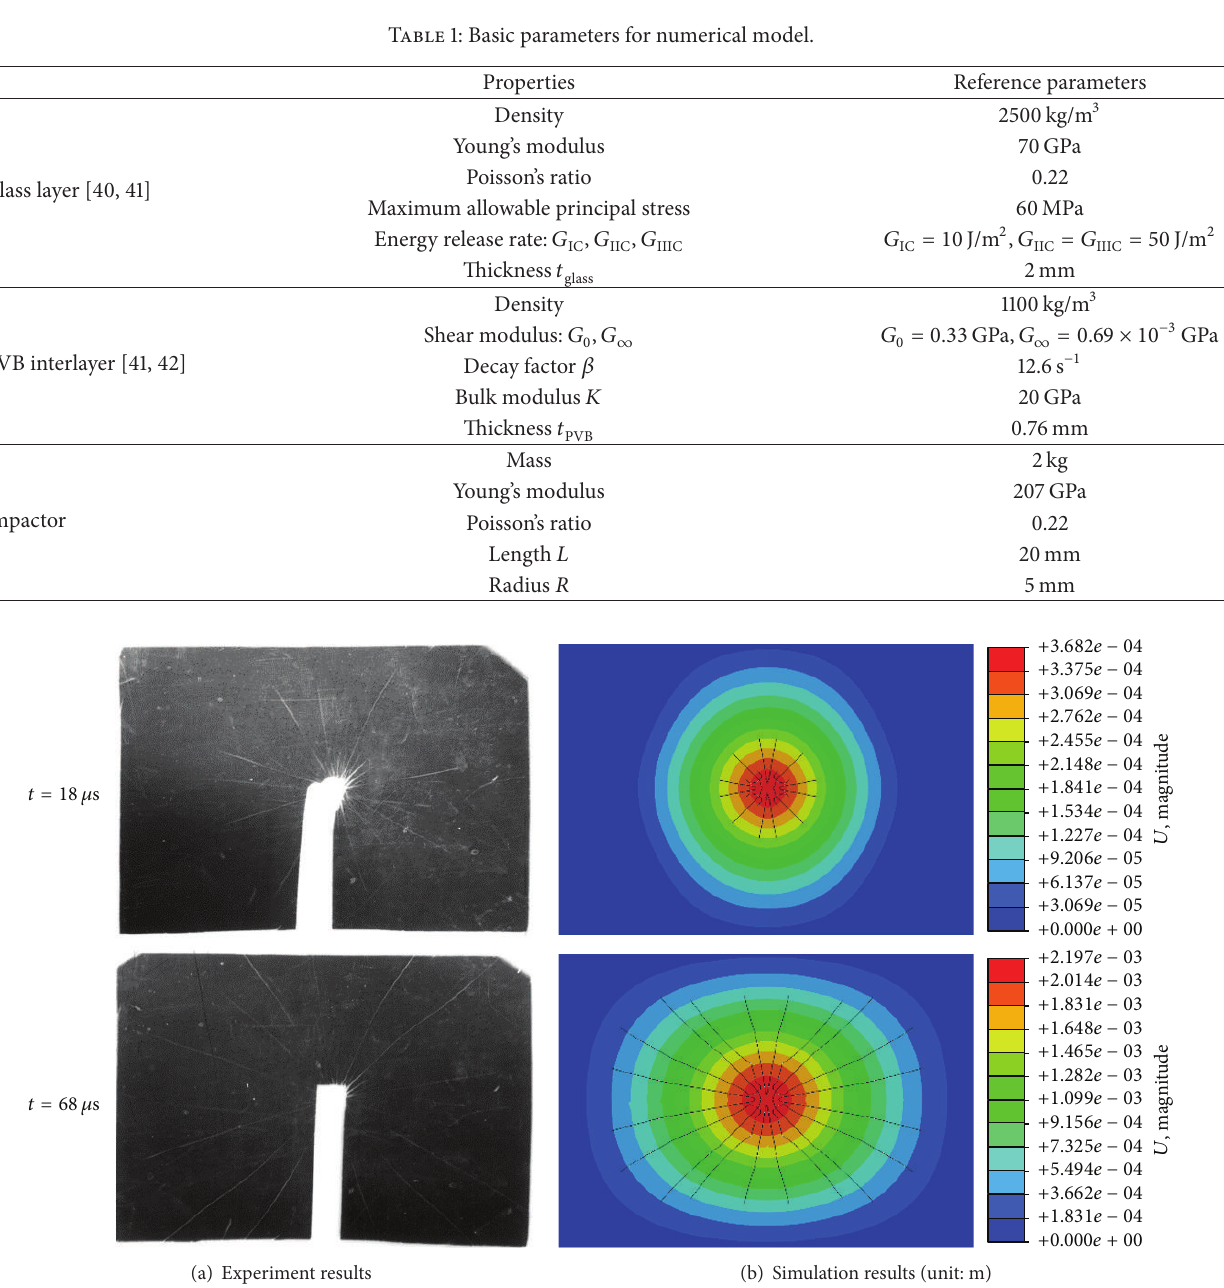
Figure 4: Qualitative verification: comparison of radial crack morphologies between simulation results and experimental